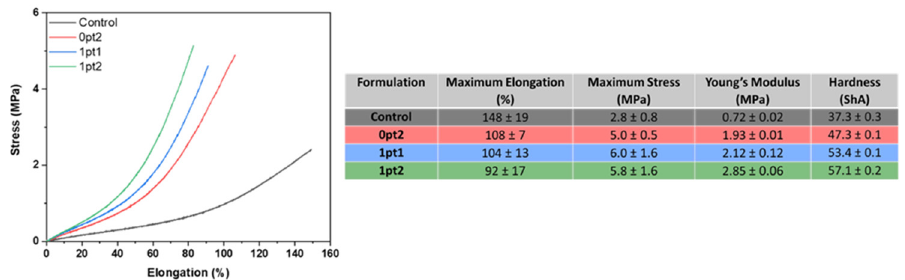
Figure 3. Mechanical properties of pristine samples.